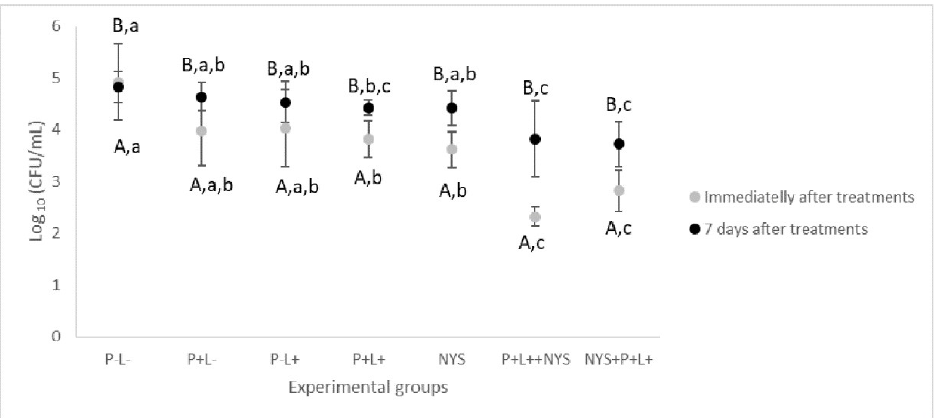
Figure 1. Mean values and standard deviation of log 10 (CFU/ml) of fluconazole-resistant C. albicans recovered from animals from all the experimental groups immediately and after 7 days of the treatments. The uppercase letters (A and B) denote statistical differences between the time intervals evaluated ( p ≤ 0.05) and the lowercase letters (a, b, and c) denote statistical differences between the experimental groups ( p ≤ 0.05, two-way ANOVA).